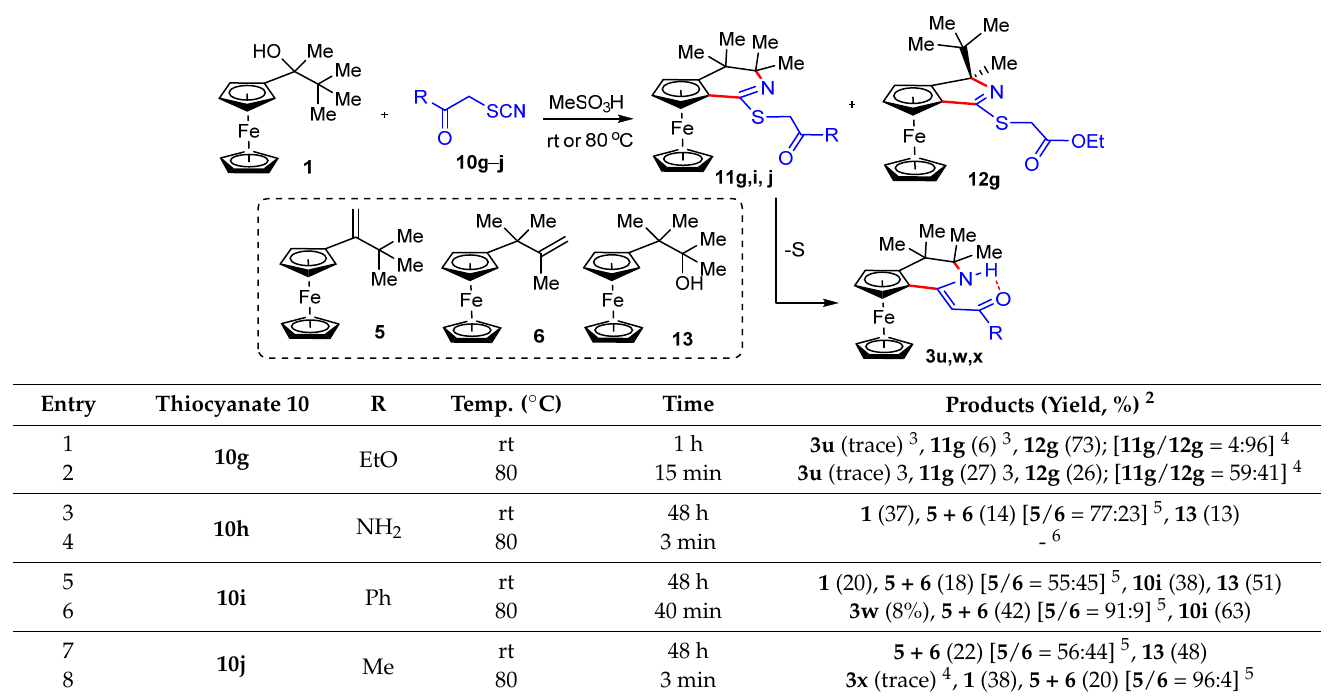
Table 6. Reaction of alcohol 1 with thiocyanates 10g – j 1 .